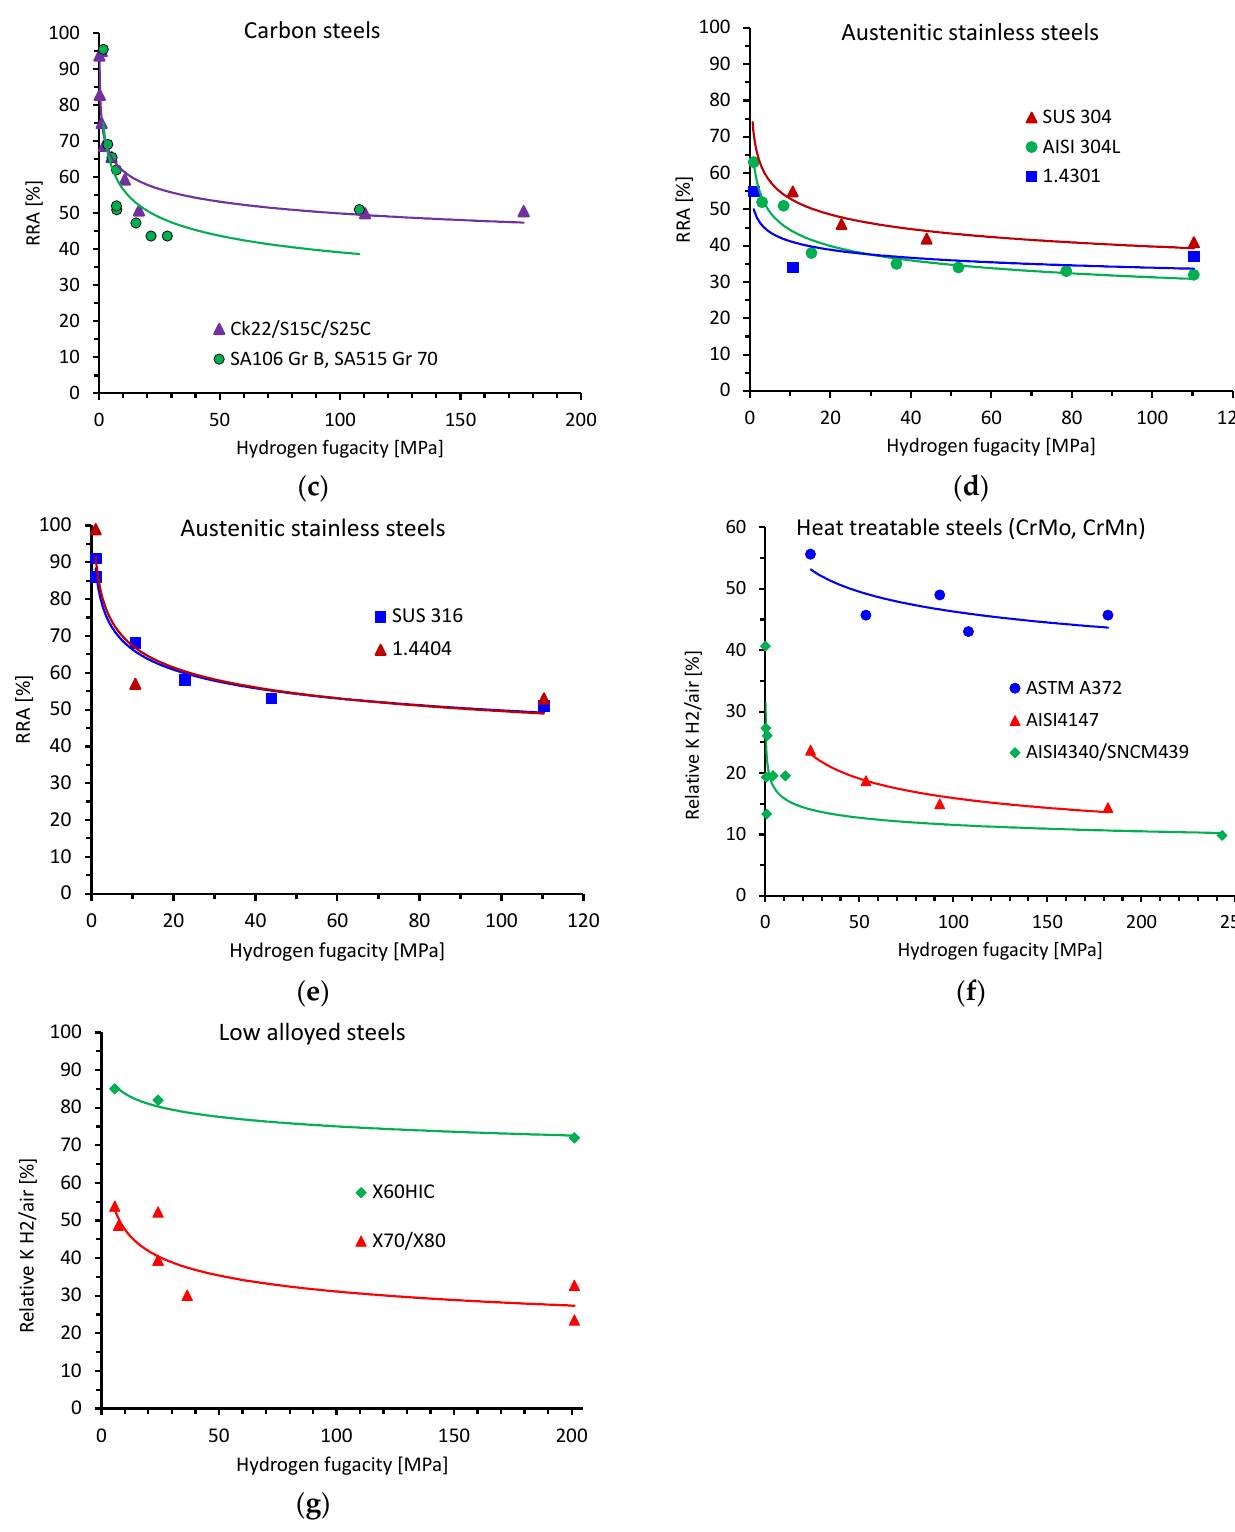
Figure 2. Results of the quasi-static tensile and fracture toughness tests as a function of hydrogen fugacity. Relative reduction of area (RRA) in the tensile tests for ( a , b ) heat-treatable steels, ( c ) carbon steels, ( d , e ) austenitic stainless steels. Relative fracture toughness of ( f ) heat-treatable steels, ( g ) low alloyed pipeline steels. References, test details and fit parameters are given in Table 1.